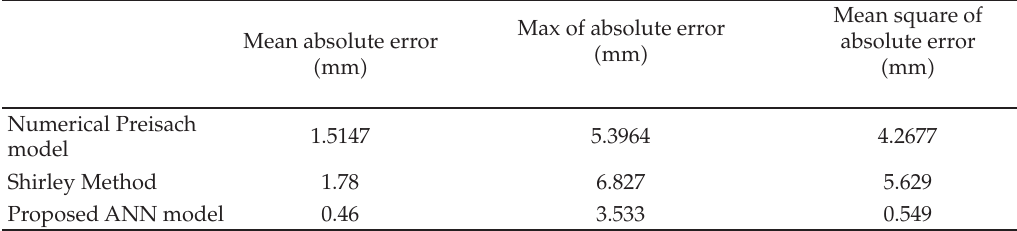
Table 4: Error of the three considered models in the second validation